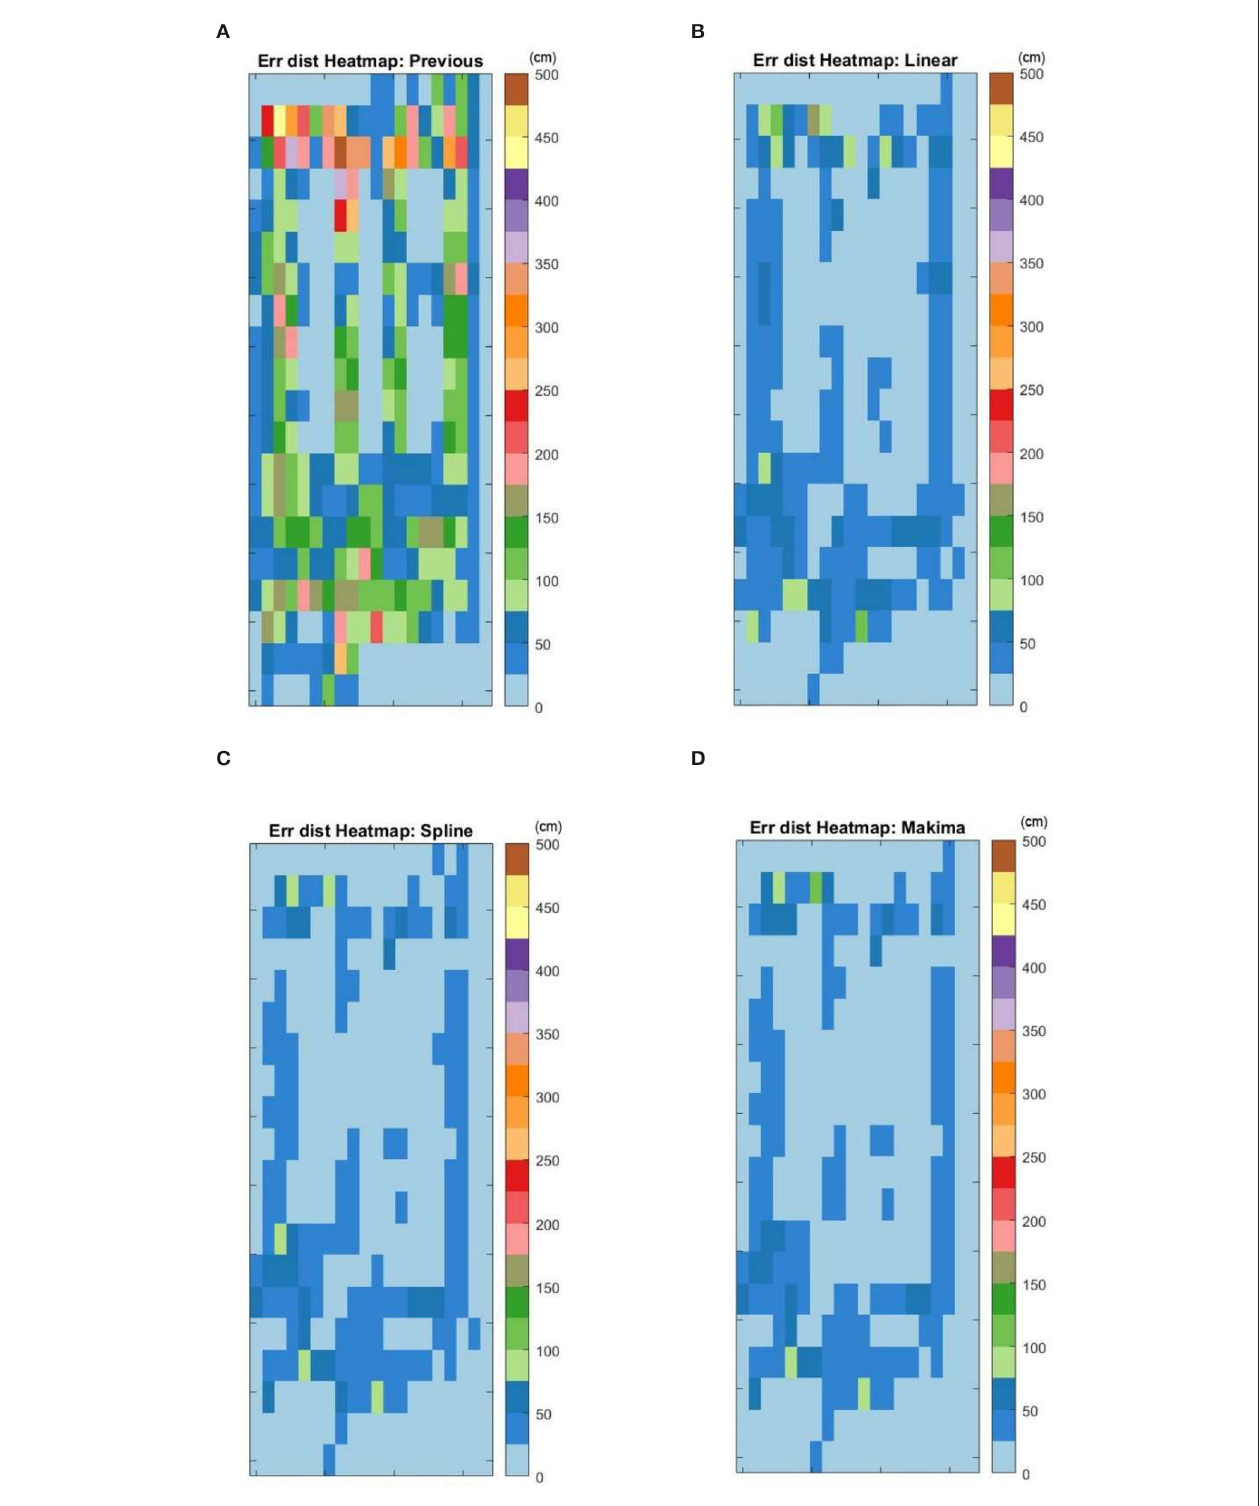
FIGURE 4 | Mean error distance in each grid square of the floorplan was calculated to investigate where the larger error distances occurred according to the layout of the barn. (A) Mean error distances using Previous position. (B) Mean error distances using Linear interpolation. (C) Mean error distances using Spline interpolation. (D) Mean error distances using modified Akima